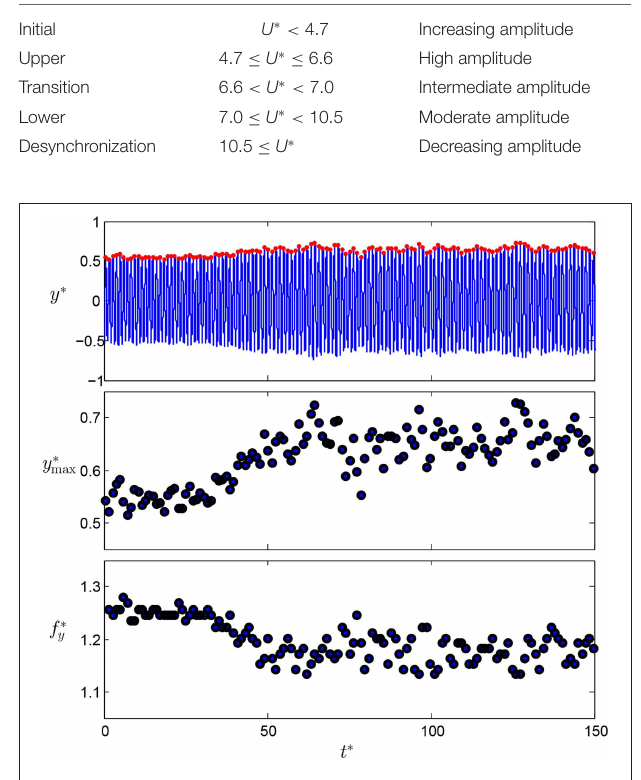
FIGURE 3 | Cycle-to-cycle variations in the amplitude and frequency of oscillations in the displacement signal at U ∗ =